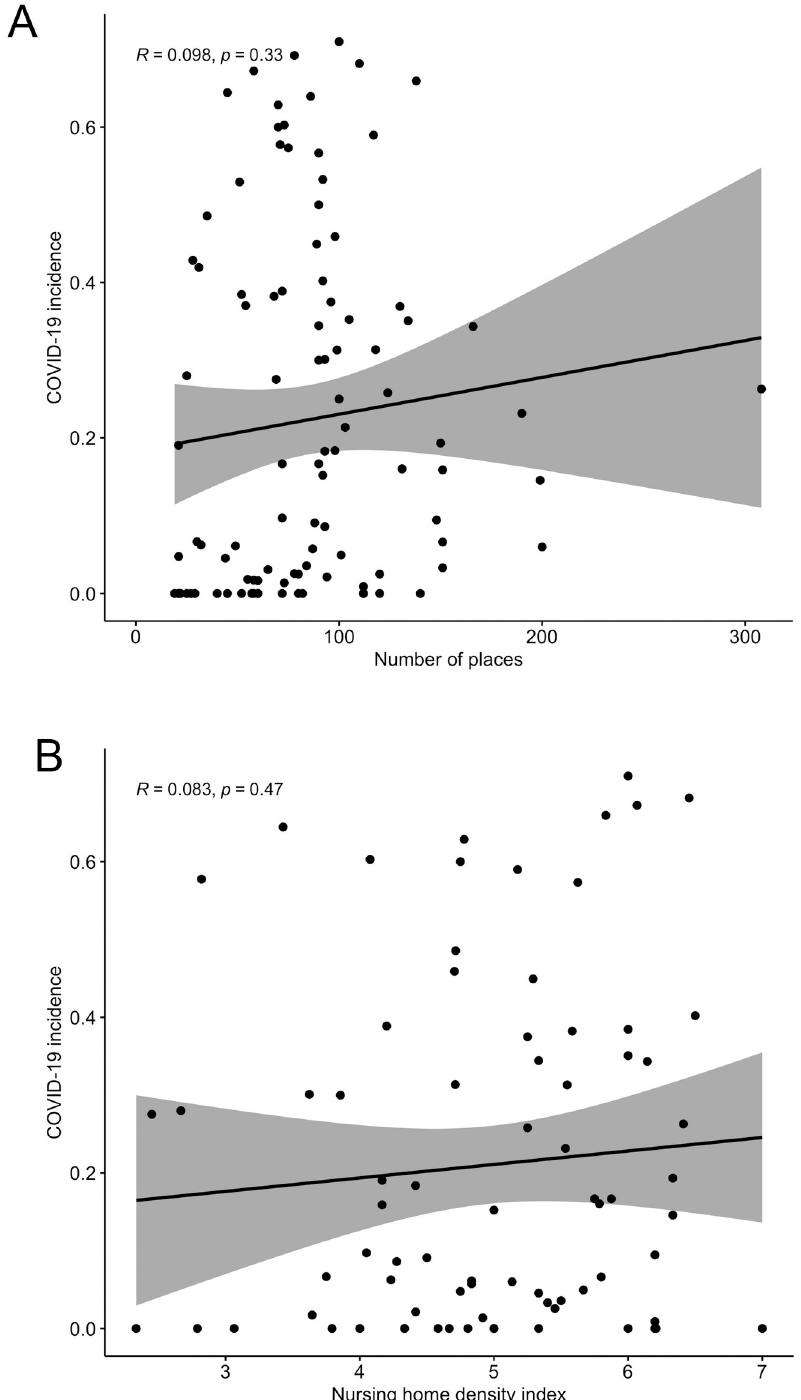
Fig 3. Incidence vs density of the institution. Legend: Panel A–Correlation between incidence of Covid 19 and number of places of the facility. Panel B–Correlation between incidence of Covid 19 and the nursing home density